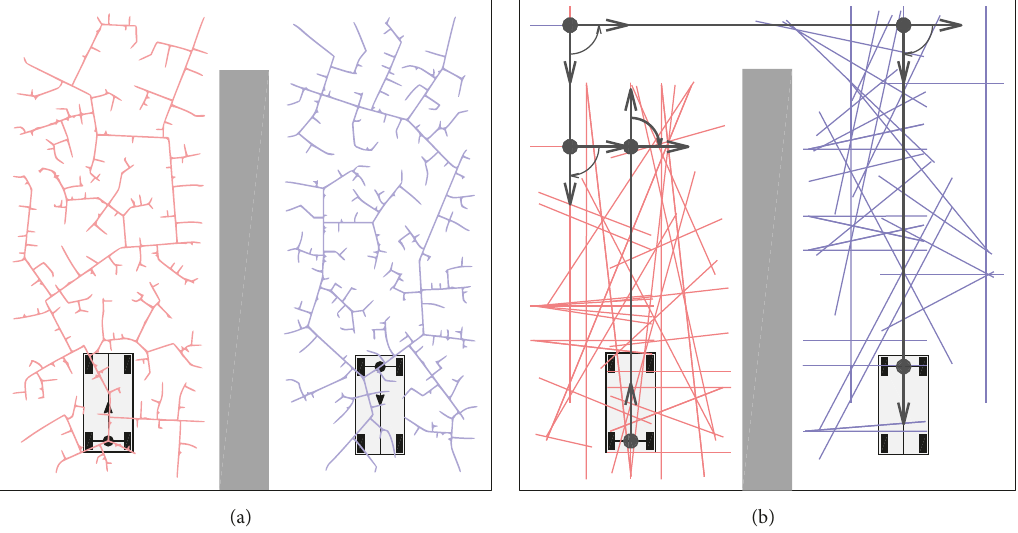
Figure 10: Illustration of RRT and RTR global planning. (a) RRT trees after 1000 iterations and (b) RTR trees and solution path after 65 iterations.